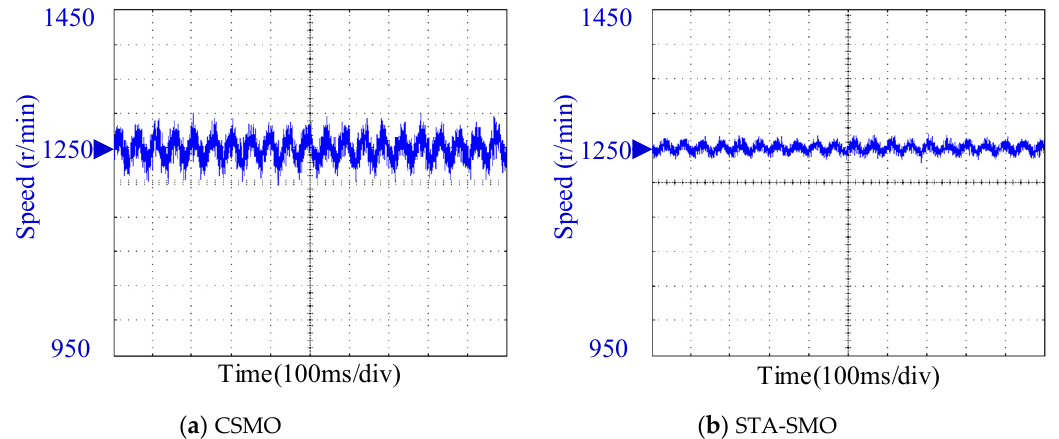
Figure 11. Experimental curves of the rotor position estimation.